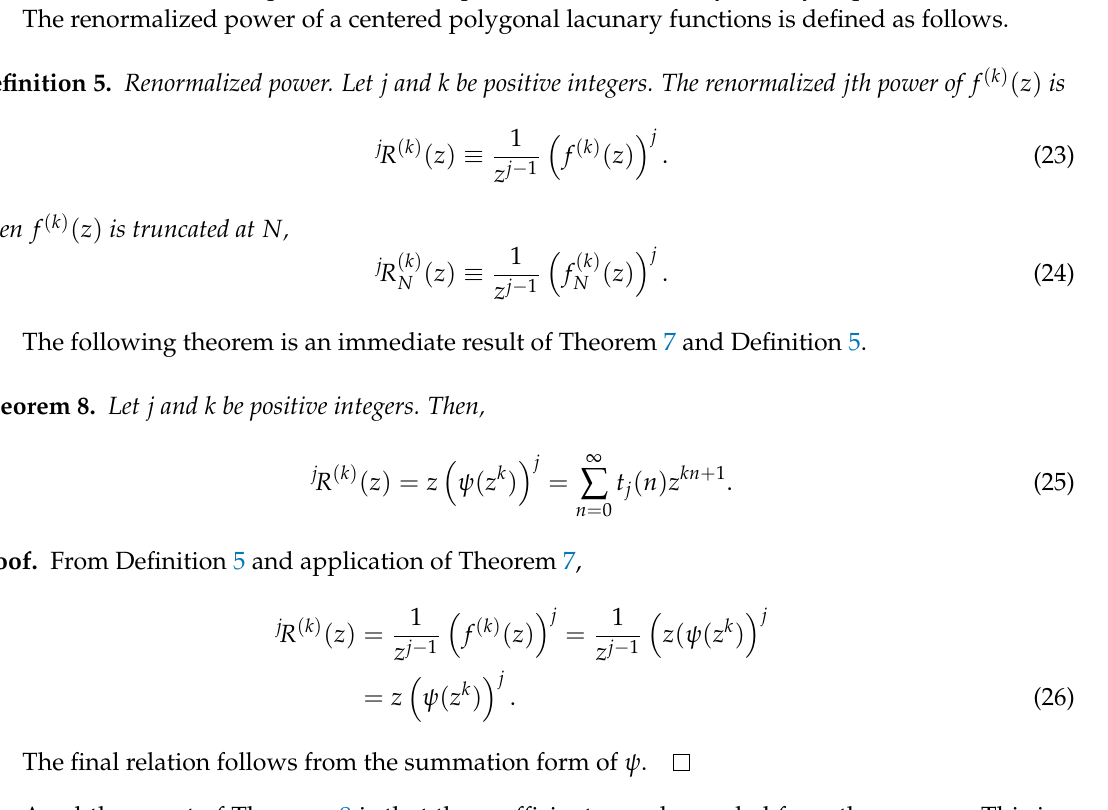
Figure 6. Renormalized ( a ) and non-renormalized ( b ) cubic power of f (cid:16) (cid:17) 3 ( k ) f , respectively. In general, renormalization produces a more convex unity level set as compared 10 to the non-renormalized